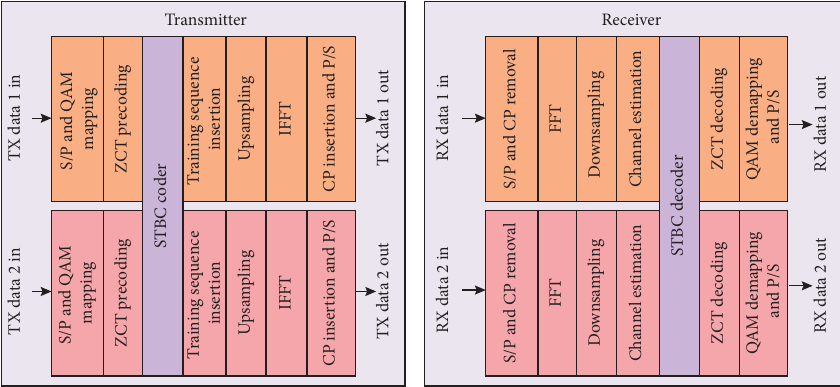
Figure 1: Block diagram of the proposed MIMO-OFDM VLC system with ZCT